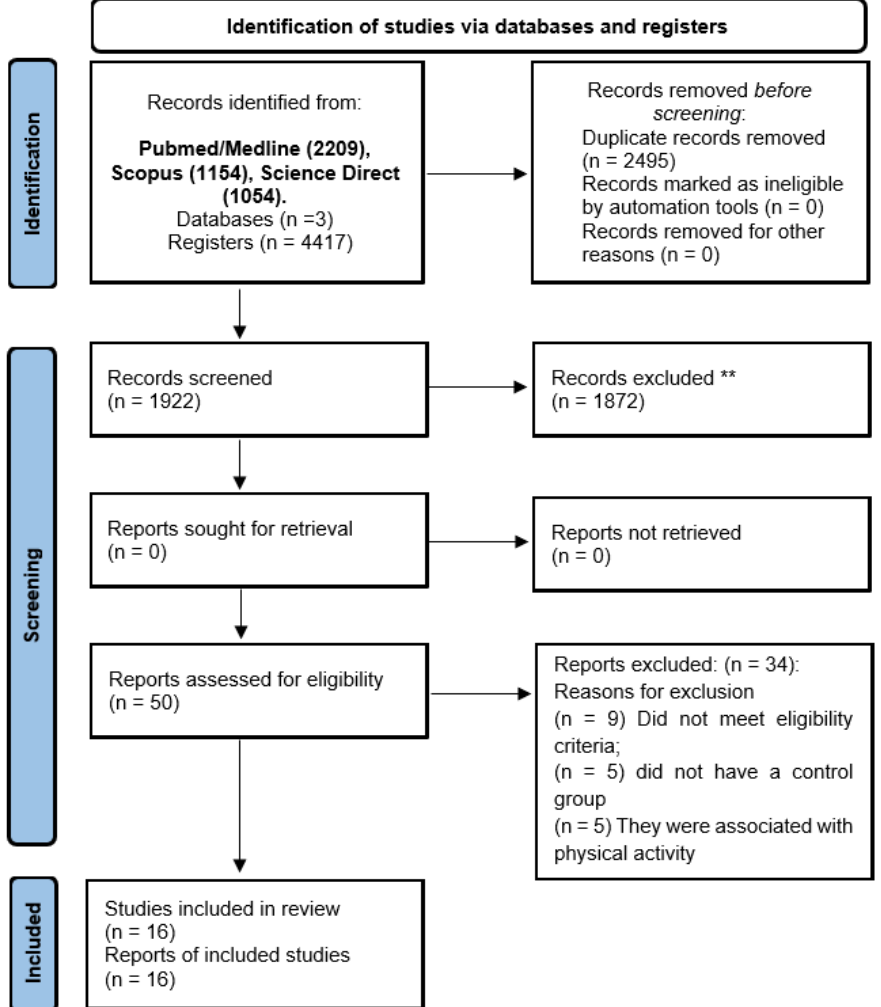
Figure 1. PRISMA 2020 flow diagram for new systematic reviews which included searches of databases and registers only. Consider, if feasible to do so, reporting the number of records identified from each database or register searched (rather than the total number across all databases/registers); ** If automation tools were used, indicate how many records were excluded by a human and how many were excluded by automation tools.